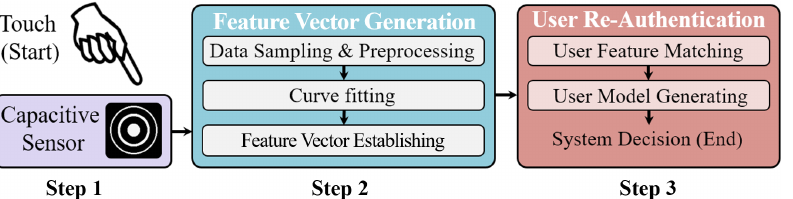
Figure 1. During touching operation, BioTouch transparently verifies the current user’s legitimacy through the following three steps: Combined user feature collection (Step 1, Section 4), user feature vector generation (Step 2, Section 5) and user re-authentication (Step 3, Section